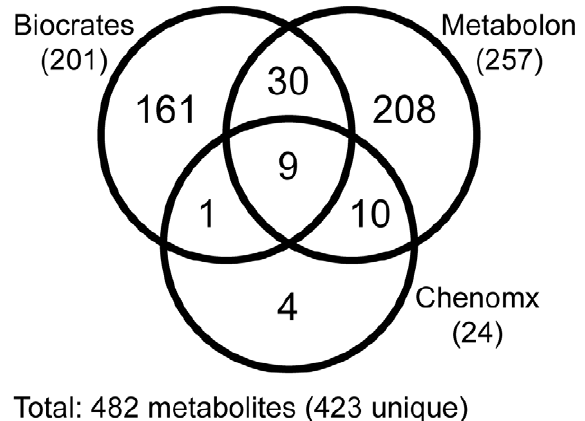
Figure 1. Venn diagram showing the number of metabolites common to all three platforms, to two platforms and metabolites detected specifically by one platform. The identity of the individual metabolites that are measured on each platform is provided in Table S2. Note that the metabolites metabolites that are quantified uniquely on the Biocrates platform carry specific information on the lipid side-chain composition of the different phospholipid classes (sometimes also referred to as lipidomics). The Metabolon platform, in contrast, provides a wider non-targeted, but semi-quantitative coverage of the general metabolome. NMR presently allows quantifying only a smaller set of metabolites, but this at a much higher degree of reproducibility, faster, and without specific sample